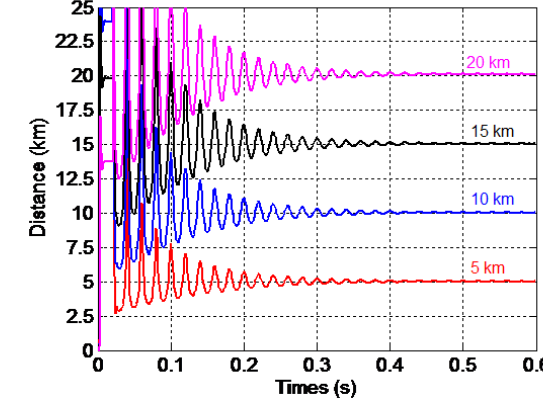
Fig. 12: Fault location as function of time using the re- actance for double-phase fault without